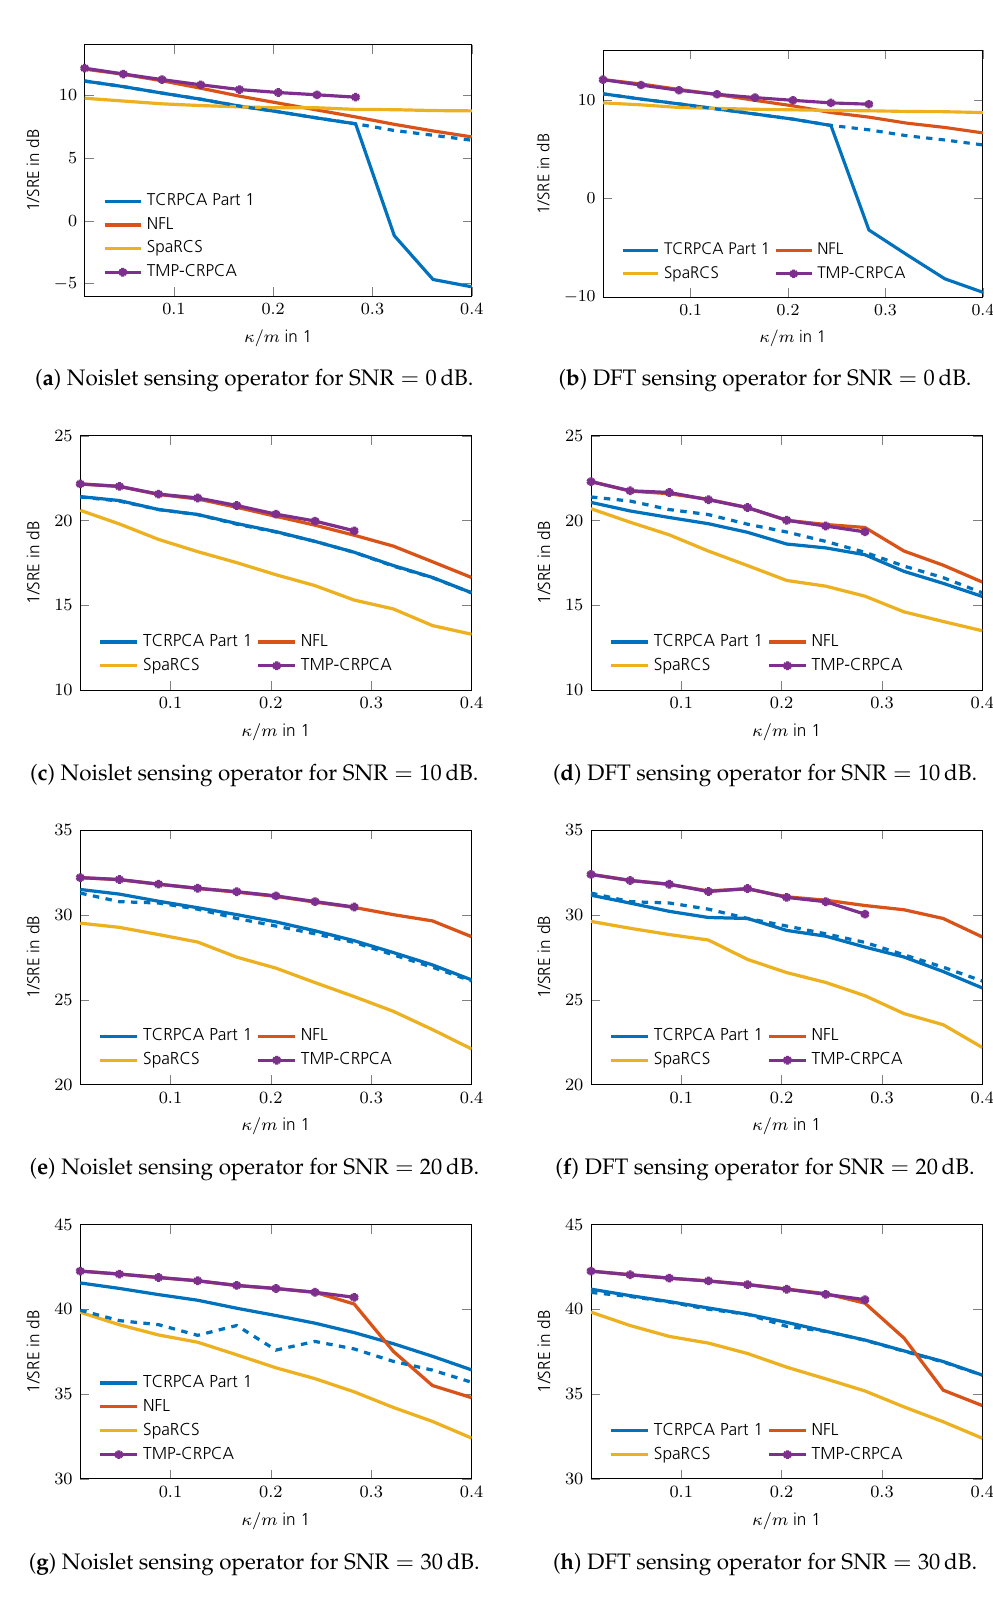
Figure 20. Comparison of the low-rank SRE vs. SNR for m / n = 0.8. The solid line for TCRPCA shows the performance without and the dashed line with the spikiness operator P ϕ ( L ) defined in (64),